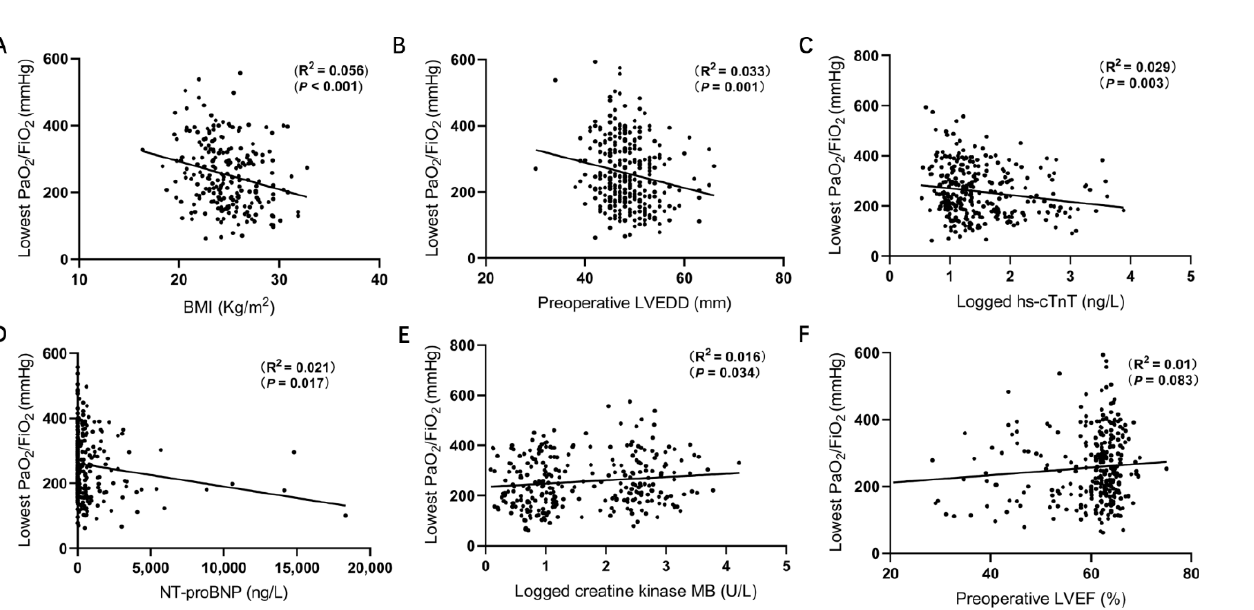
Figure 1. The correlation between lowest postoperative PaO 2 /FiO 2 levels and baseline character- istics. Postoperative PaO 2 /FiO 2 was significant correlated with ( A ) BMI (r 2 = 0.056; p < 0.001), ( B ) Preoperative LVEDD (r 2 = 0.033; p = 0.001), ( C ) Hs-cTnT (r 2 = 0.029; p = 0.003), ( D ) NT-proBNP levels (r 2 = 0.021, p = 0.017), ( E ) Creatine kinase MB (r 2 = 0.016; p = 0.034), but not correlated with ( F ) Preoperative LVEF (r 2 = 0.01; p =